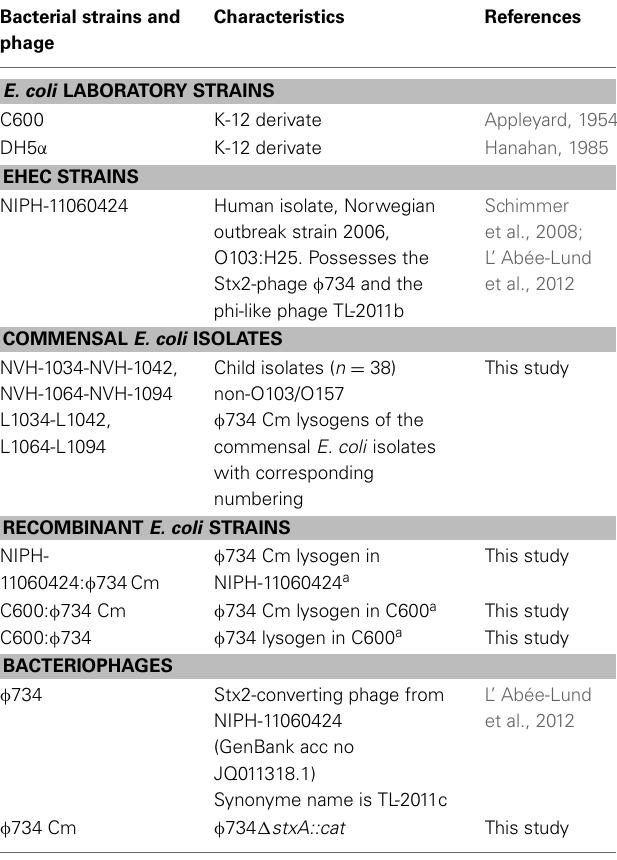
Table 1 | E. coli strains and bacteriophages used in the